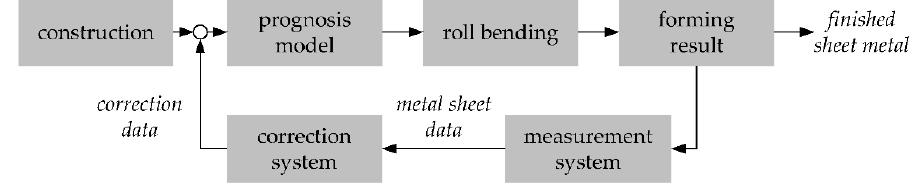
Figure 2. Control approach consisting of a predictive model and a measurement system.